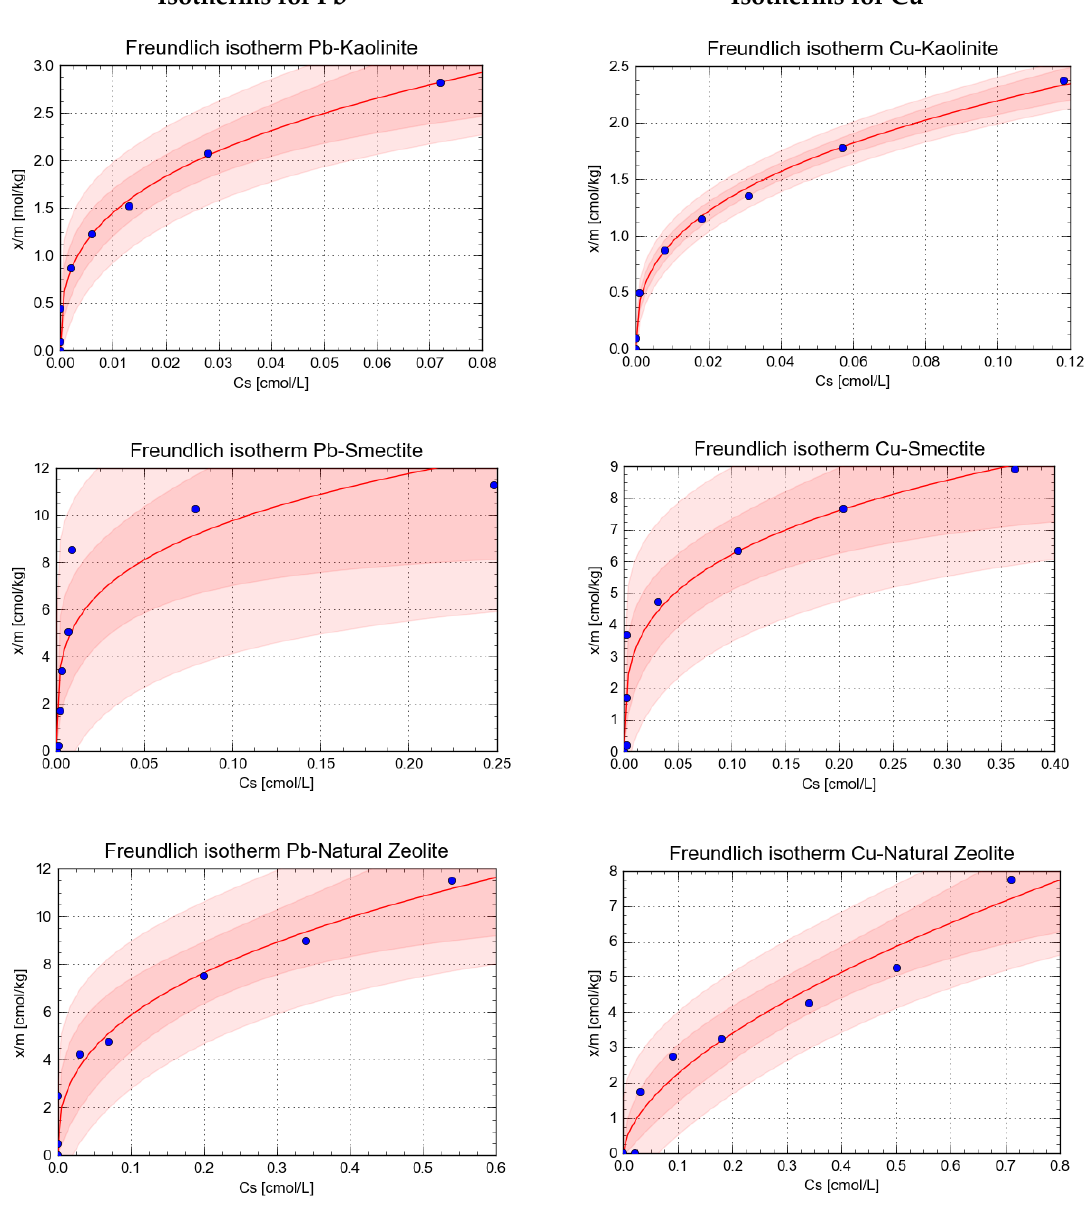
Figure 1. The Freundlich isotherms obtained in the study for sorption of Pb 2+ and Cu 2+ onto tested natural mineral sorbents.